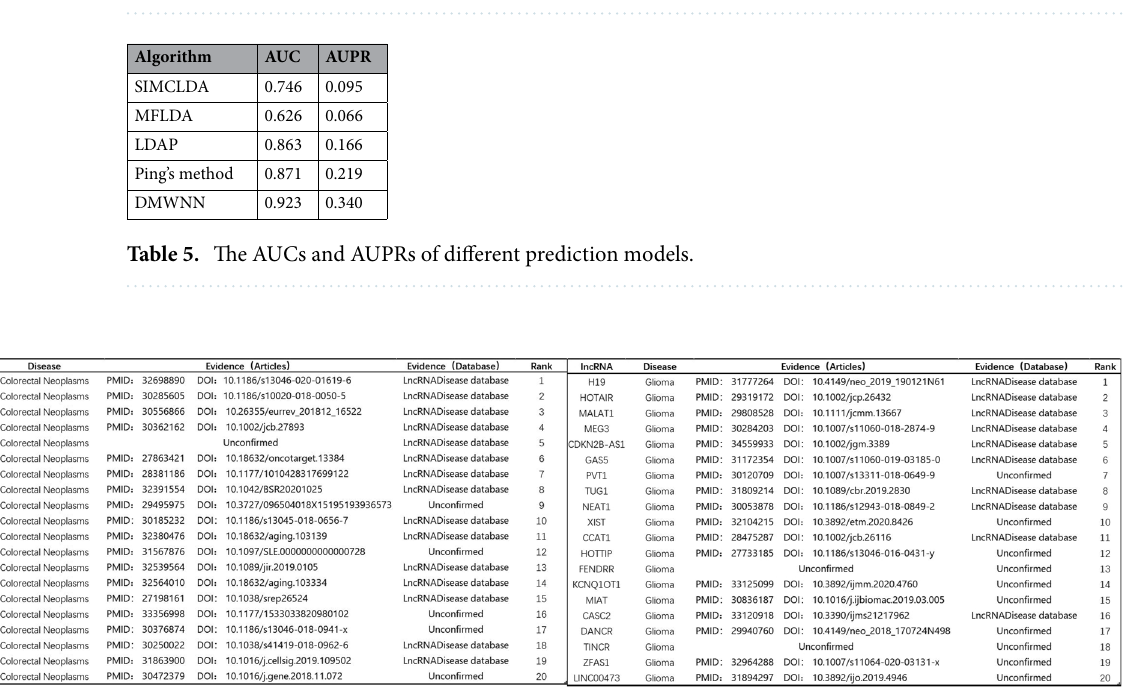
Figure 6. The performance of DMWNN in terms of ROC curves (Left) and PR curves (Right) based on 407 known lncRNA–disease associations under the LOOCV frameworks.